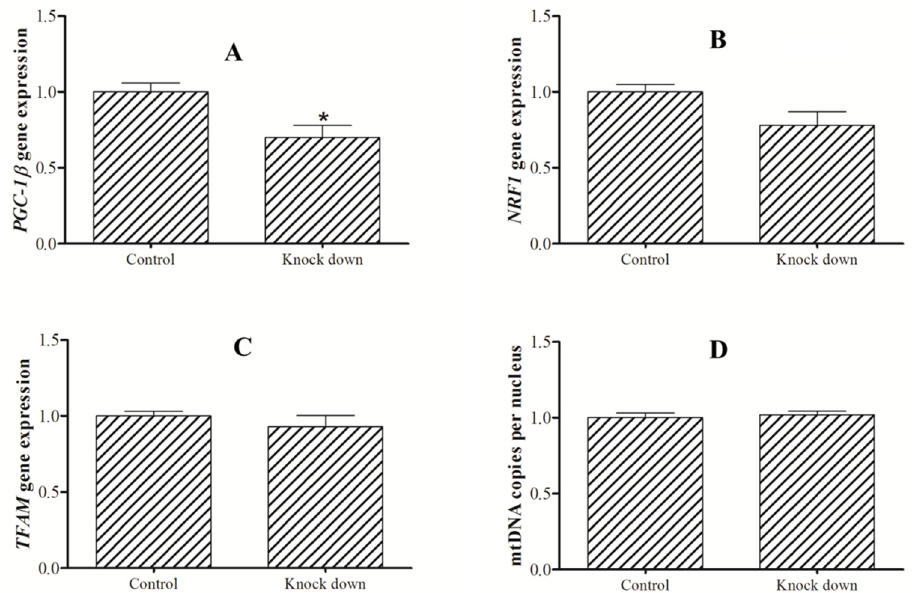
Figure 5. Expression of PGC-1 β ( A ), NRF1( B ) and TFAM( C ), and mtDNA( D ) copies after knockdown of PGC-1 β in hepatocytes of blunt snout bream ( M. amblycephala ). The asterisk indicates significant difference ( P < 0.05, Student’s t-test).